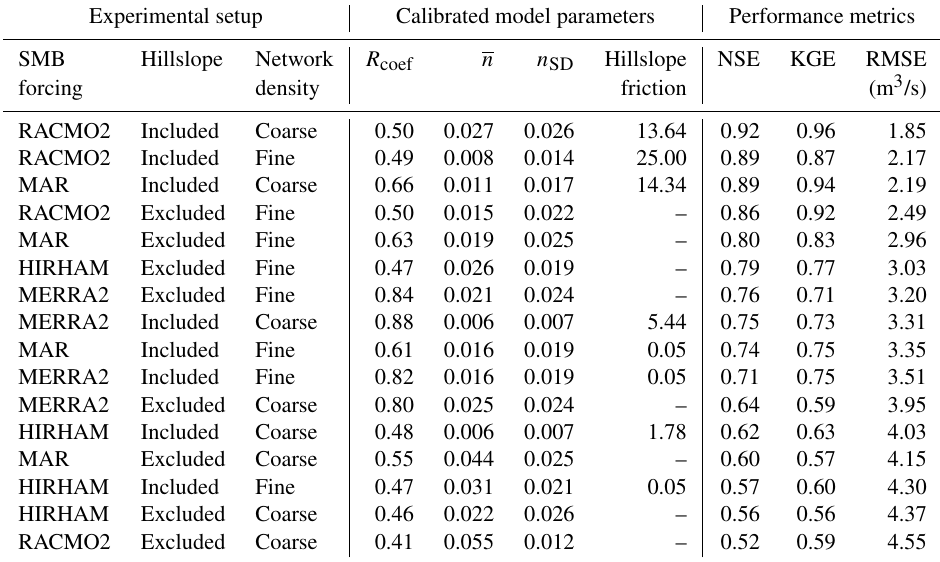
Table 2. Calibrated parameters for all 16 coupled SMB–HRR model experiments. Table is ranked by NSE per row, with the top performing model in the first row.